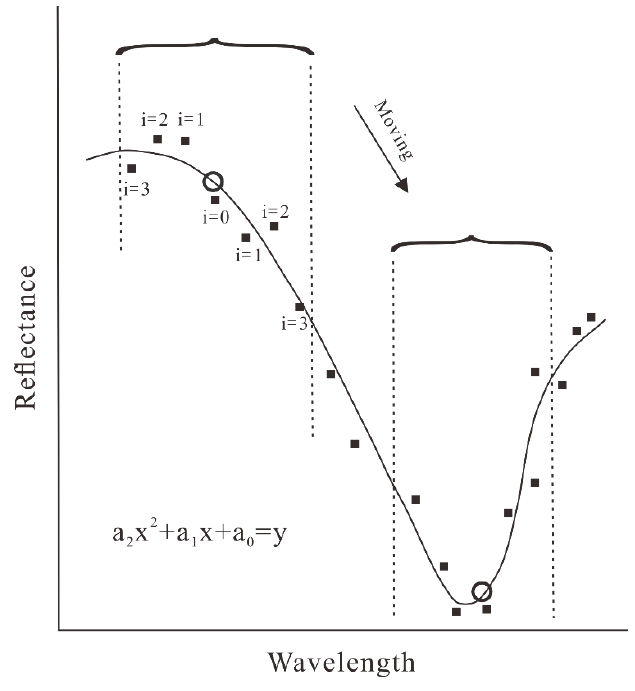
Figure 8. The principle of Savitzky–Golay filtering.